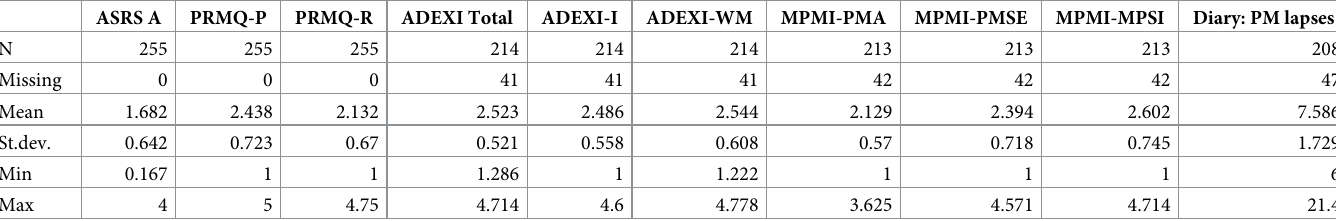
Table 1. Average responses to the questionnaires that probe into executive functions and prospective memory.